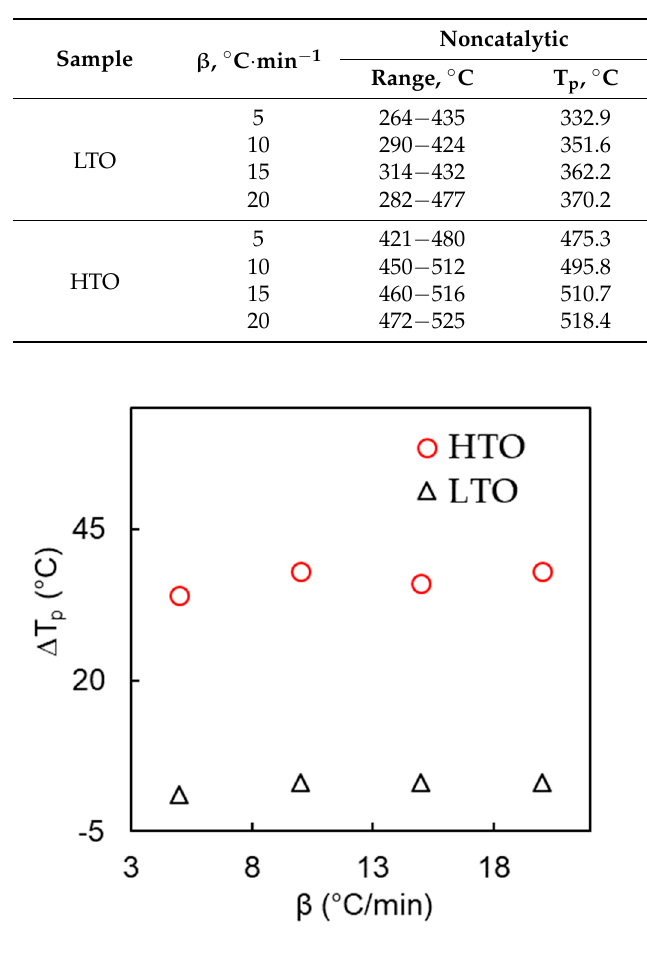
Figure 6. Differences between peak temperatures ( ∆ T p ) for catalytic and noncatalytic heavy oil oxidation at different heating rates.